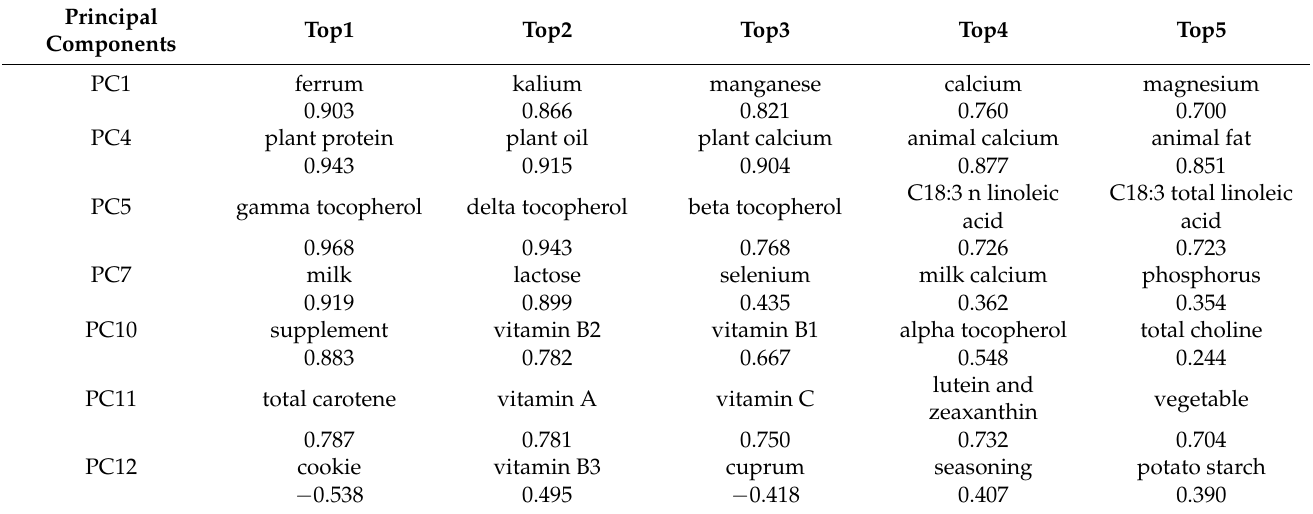
Table 6. Top five nutrients within PCs significantly correlated with HMO (and factor